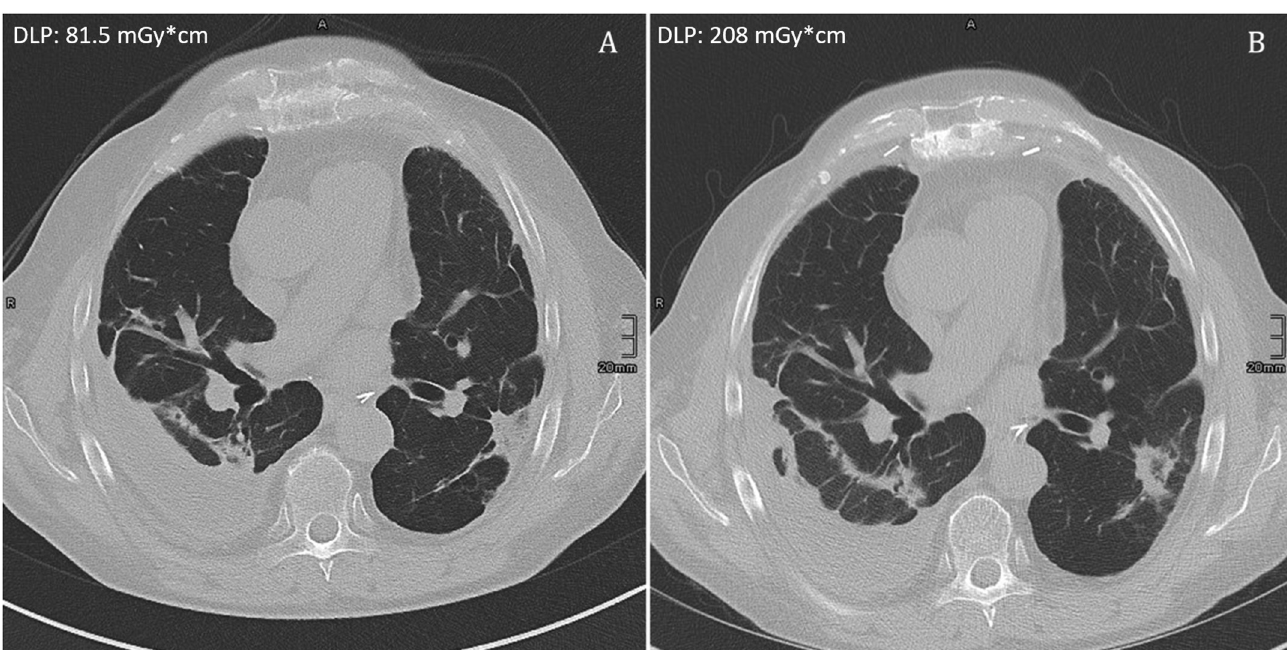
Fig 2. Example images of the two protocols with corresponding DLP. Images of both protocols with corresponding dose-length product (DLP). A) 3rd generation Sn150kVp protocol: DLP = 81.5 mGy � cm. B) 2nd generation 100kVp protocol: DLP = 208 mGy � cm.